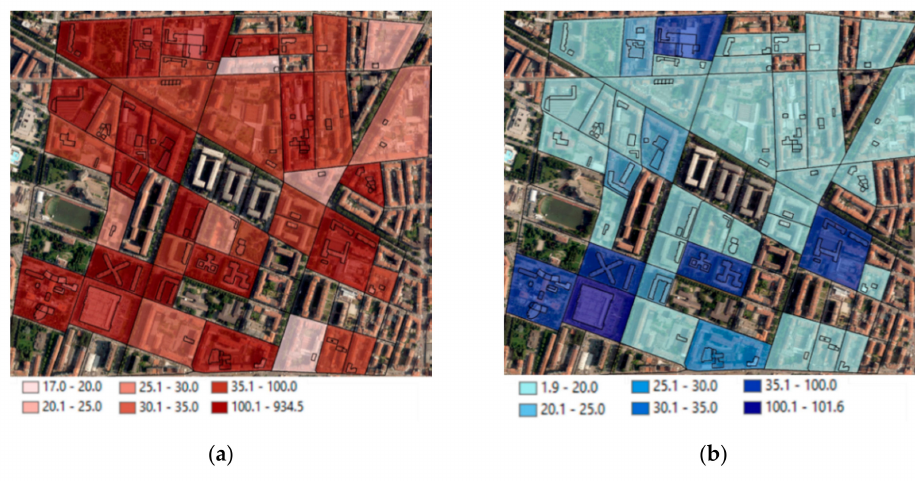
Figure 7. Green roofs’ potential assessment at block-of-building scale: ( a ) Heating and ( b ) cooling primary energy savings in MWh / year.